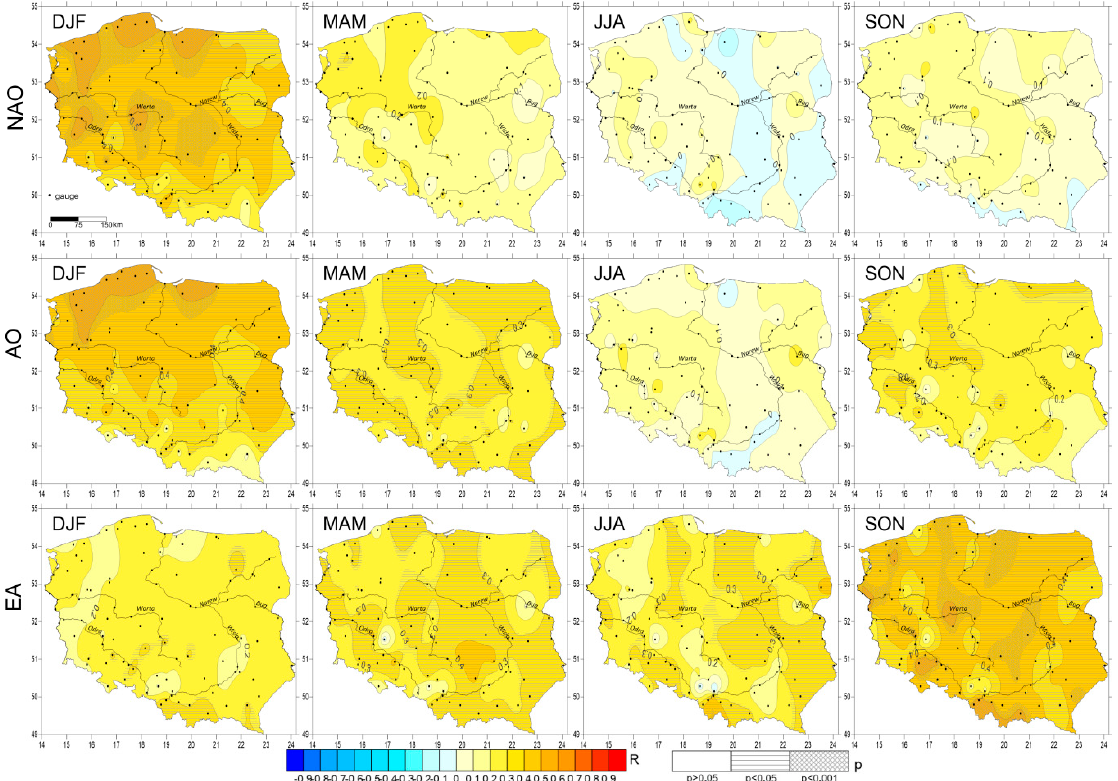
Figure 6. Spatial distribution of coefficients of correlation (R) between seasonal water temperature values and circulation types NAO, AO, and EA, and their statistical significance (p).